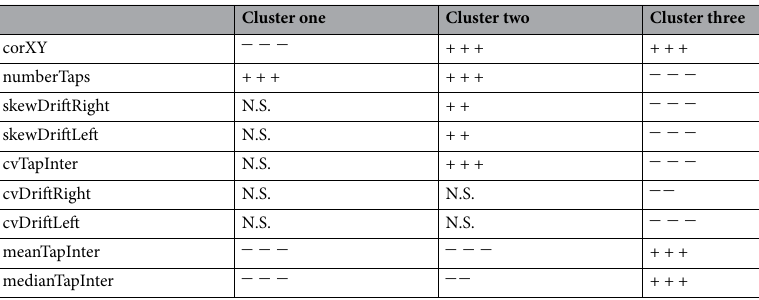
Cluster one Cluster two Cluster